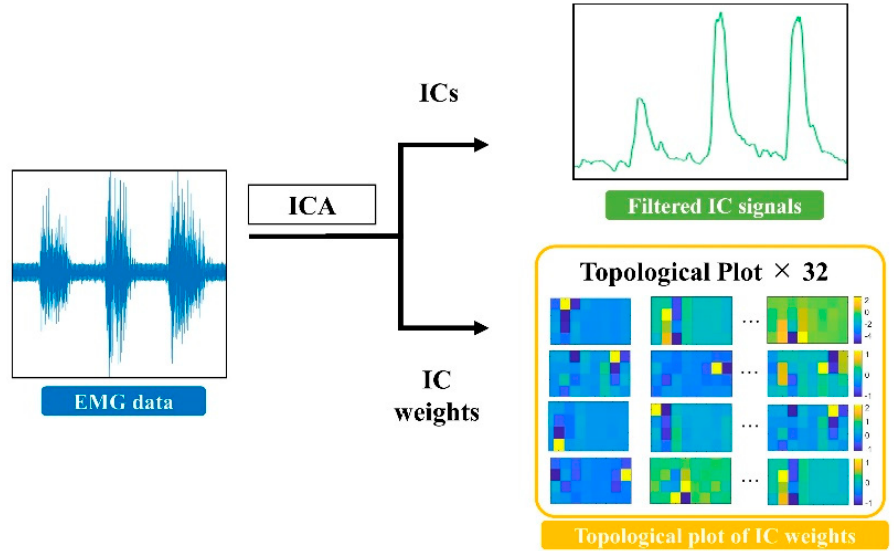
Figure 3. Independent component analysis was performed on the raw EMG data. After independent component analysis, IC signals were rectified and filtered at a cut-off frequency of 3 Hz by a low-pass filter. The weights of IC were then converted into a topological plot. The yellow locations were assigned high weight values, and the blue locations were assigned low weight values. A higher weight value indicates greater exertion in the muscles in that area during the particular motion.